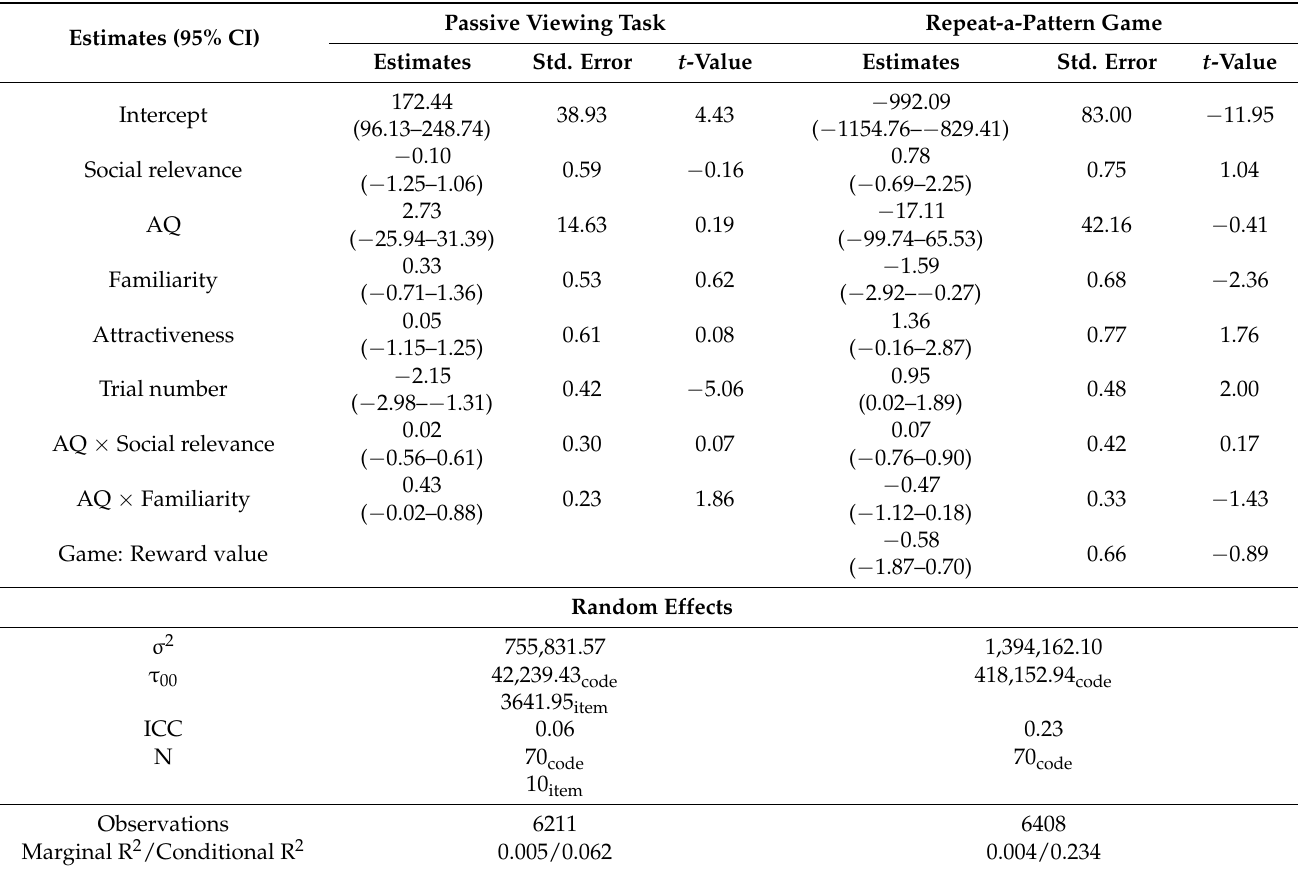
Table 3. Exploratory mixed effects models investigating the effects of autistic traits (AQ score) and their interactions with social relevance and familiarity in the game and in the passive viewing